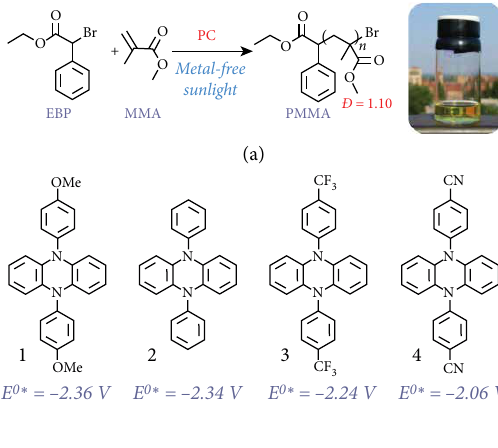
Figure 4: Proposed mechanism for a photoredox-mediated ATRP proceeding through an oxidative quenching pathway with alkyl halides (top) and the use of perylene as an organic photocatalyst for the polymerization of methyl methacrylate with alkyl bromide initiators (bottom) and a photograph of this polymerization being mediated by natural sunlight (bottom right). (Adapted with permission from Ref. [42]).